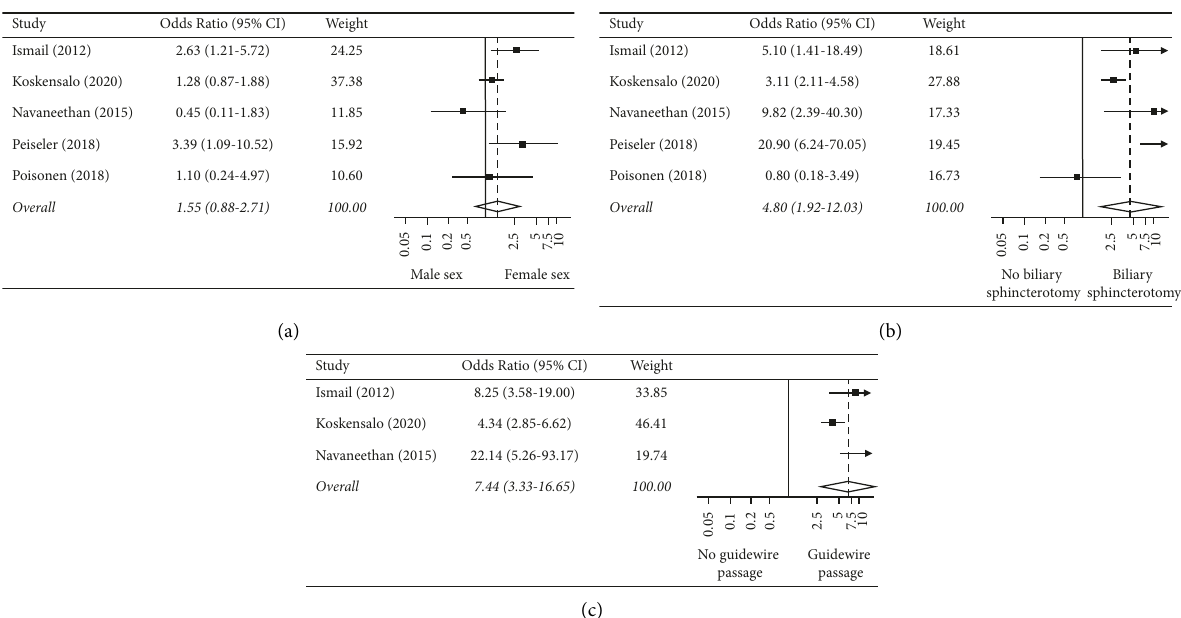
Figure 3: Forest plot of the individual and combined odds of pancreatitis based on (a) sex, (b) biliary sphincterotomy, and (c) accidental passage of the guidewire into the pancreatic